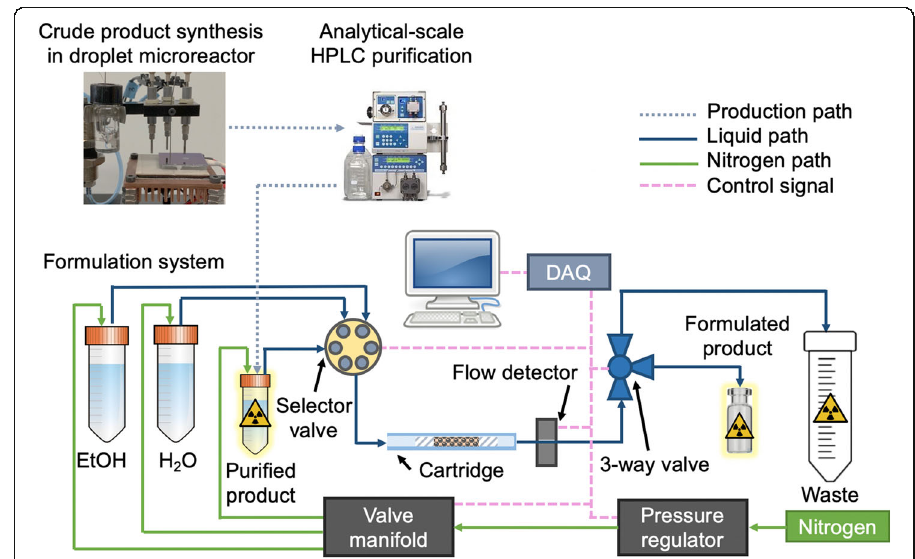
Fig. 1 Overview of microvolume synthesis procedure for [ 18 F]FBB, with detailed schematic of the formulation system